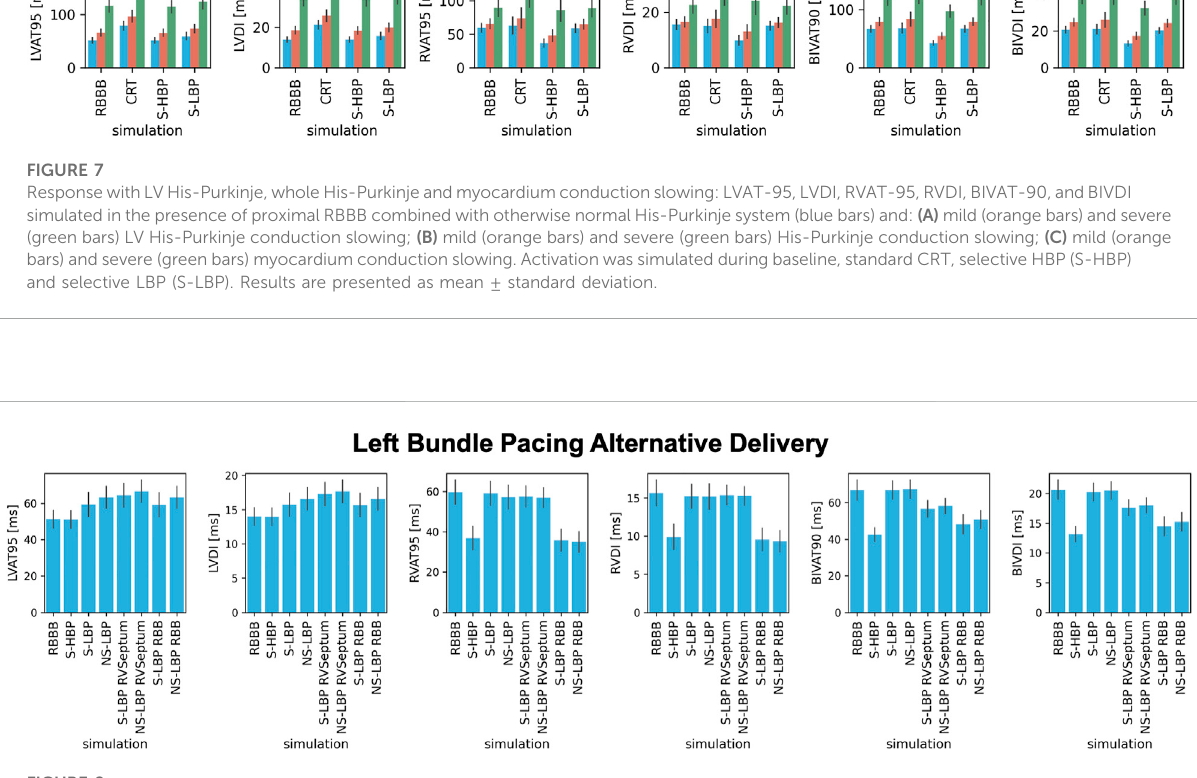
FIGURE 8 Response to different HBP and LBP delivery methods: LVAT-95, LVDI, RVAT-95, RVDI, BIVAT-90, and BIVDI simulated in the presence of proximal RBBB. Activation was simulated during baseline, selective HBP (S-HBP), selective LBP (S-LBP), non-selective LBP (NS-LBP), selective and non-selective LBP with RV septum myocardial anodal capture (S-LBP RVSeptum and NS-LBP RVSeptum) and selective and non-selective LBP with right bundle anodal capture (S-LBP RBB and NS-LBP). Results are presented as mean ± standard